Question: According to this chart, does the measure grow or shrink?
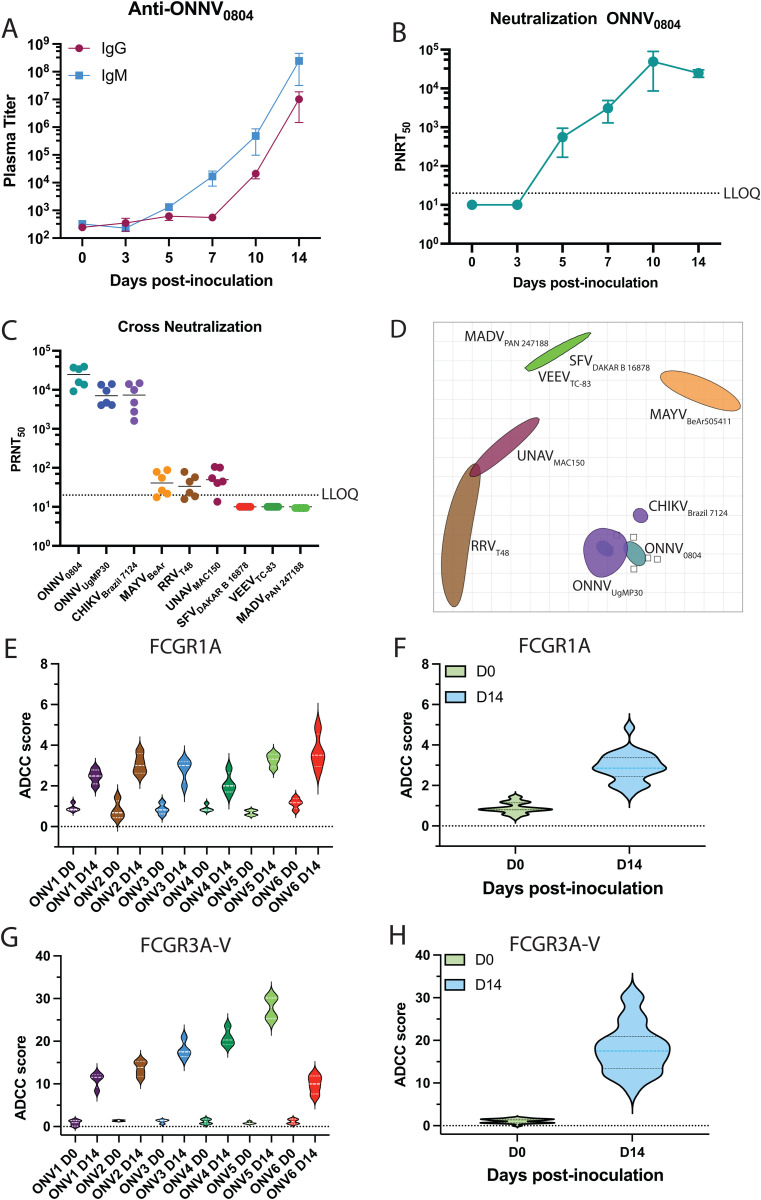
Answer: increasing